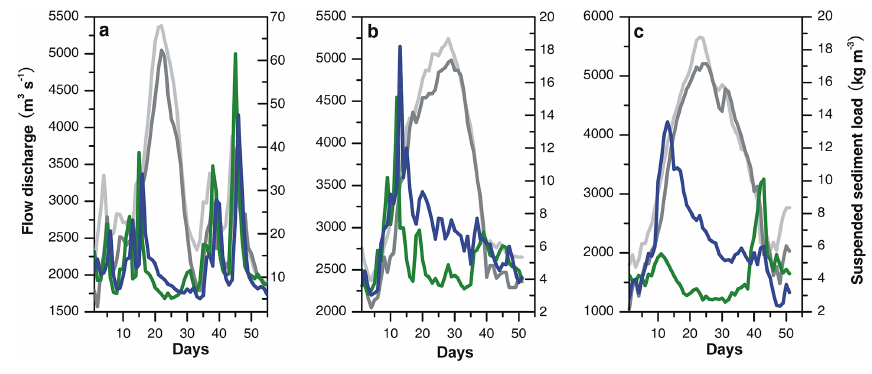
Figure 9. Daily suspended sediment loads and flow discharges of three flow peaks ( > 4000m 3 s − 1 ) flowing through the Ulan Buh desert braided channel. (a) 5050m 3 s − 1 flow discharge peak on 31 July 1964; (b) 4990m 3 s − 1 flow discharge peak on 16 September 1967; (c) 5210m 3 s − 1 flow discharge peak on 21 September 1981. Light grey and grey lines depict curves of flow discharges monitored in Shizuis- han and Bayangaole gauges, respectively; olive-green and blue lines depict curves of suspended sediment loads monitored in Shizuishan and Bayangaole gauges, respectively.